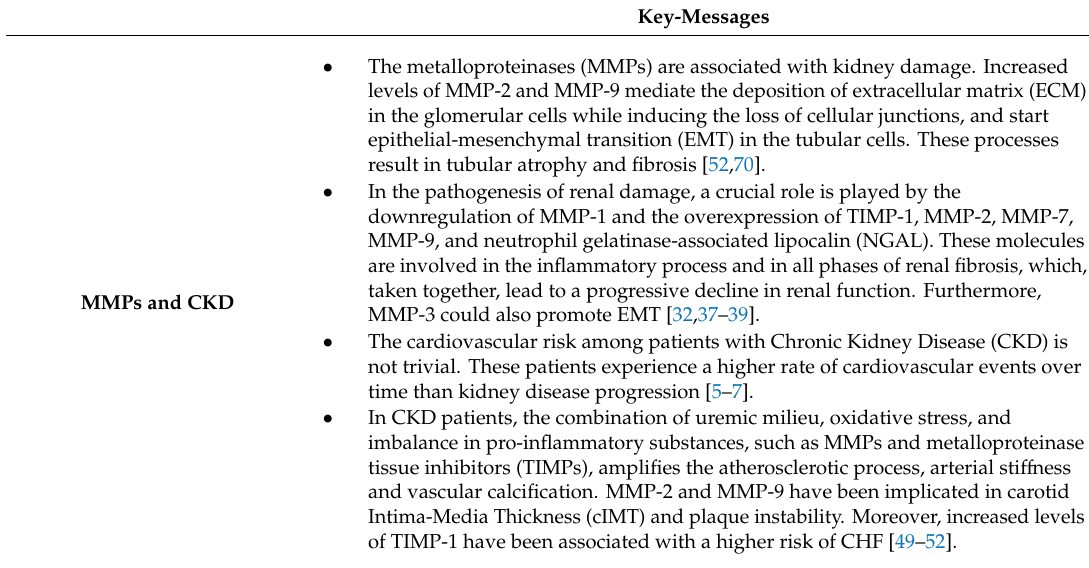
Table 1. Summary of main paper